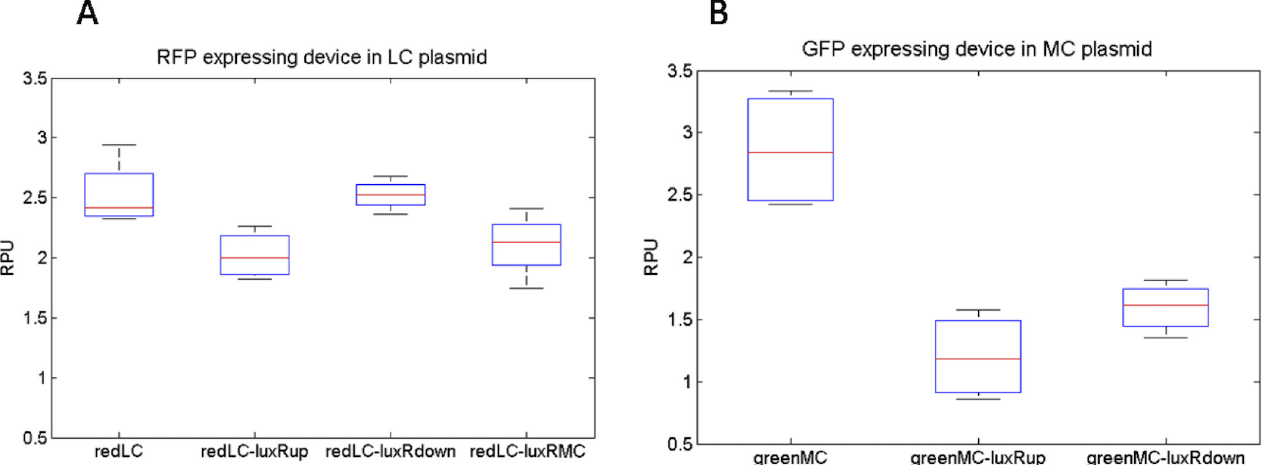
Fig 7. Boxplots showing the LuxR-repressible J107100 promoter activity in presence of a LuxR expression cassette in different positions. The description of the tested contexts is provided in the